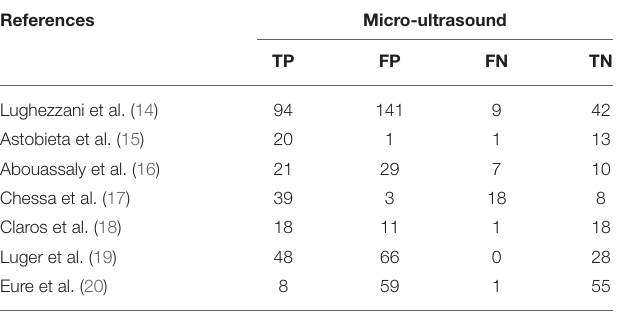
TABLE 2 | Summary of results of micro-ultrasound in included studies.